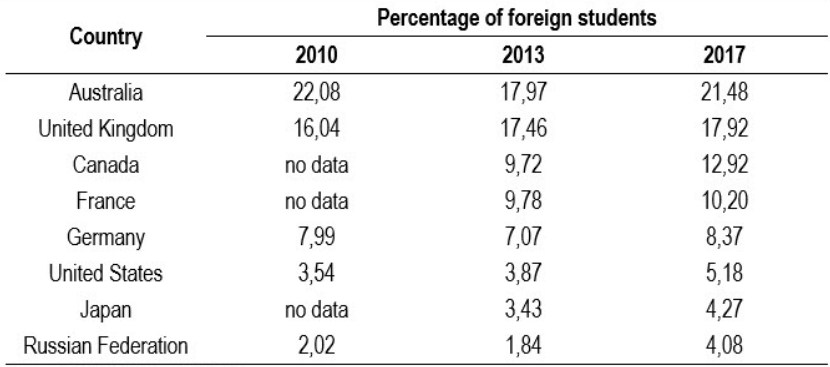
Percentage of foreign students in the given country (2010, 2013,